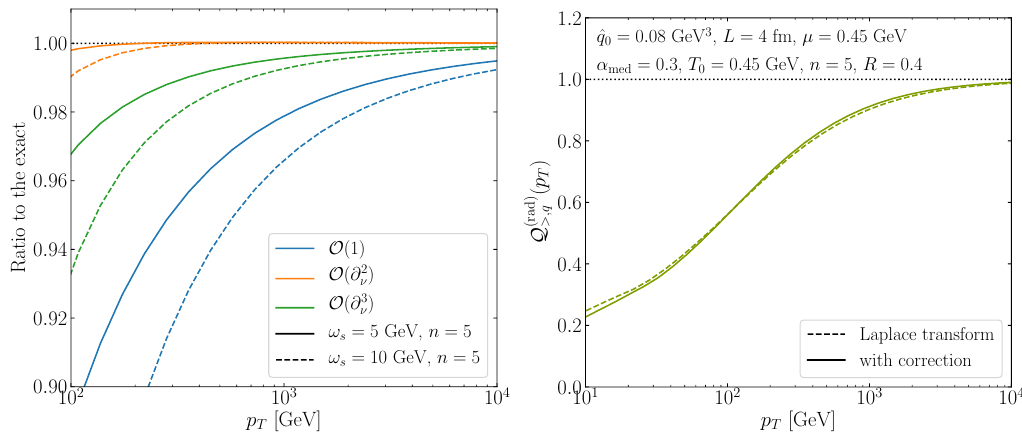
with correction